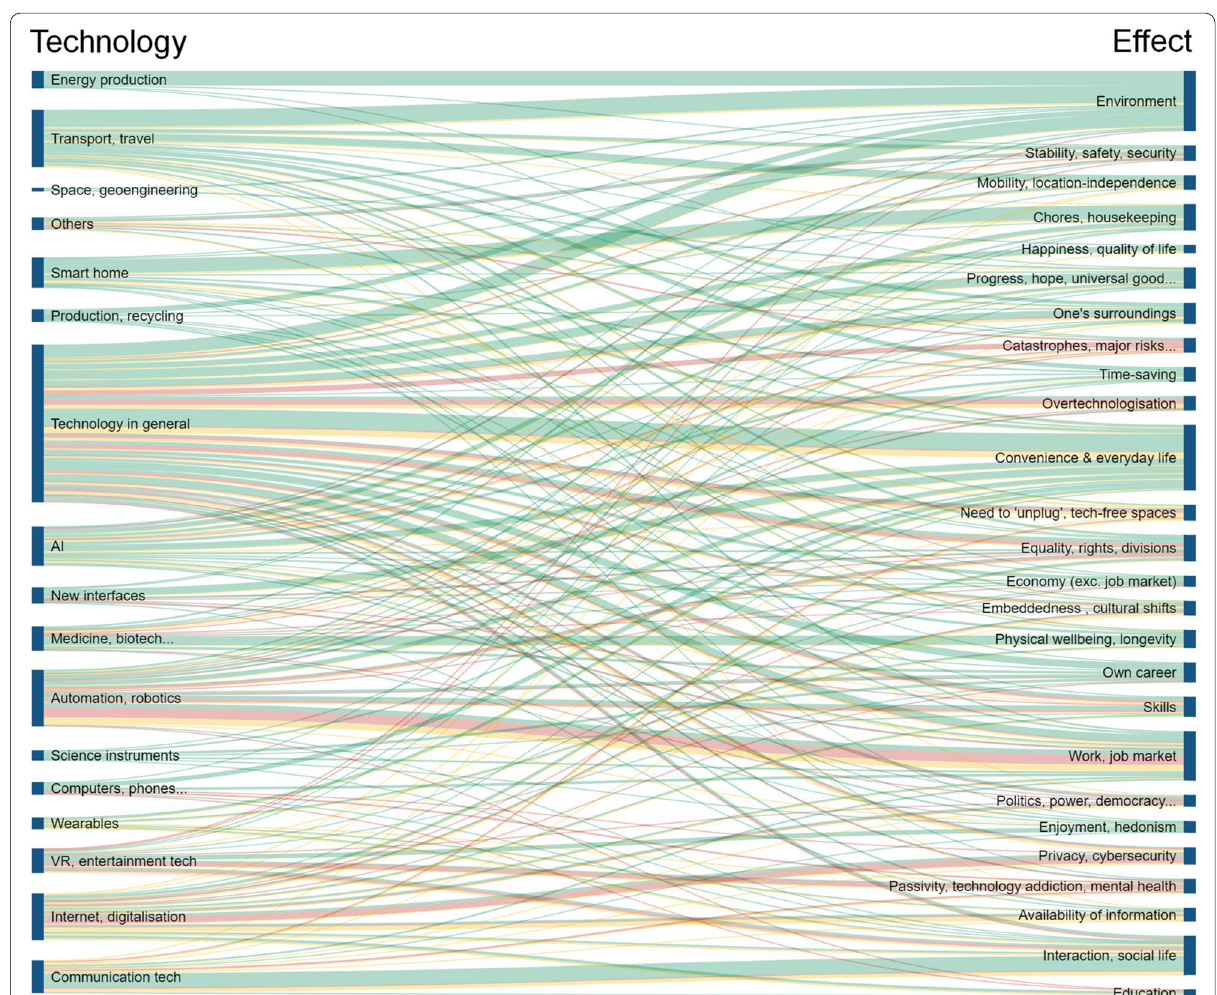
Fig. 1 The connections between technologies and their effects. The width of the lines indicates the frequency of the connection. Green colour indicates positively, yellow neutrally and red negatively depicted